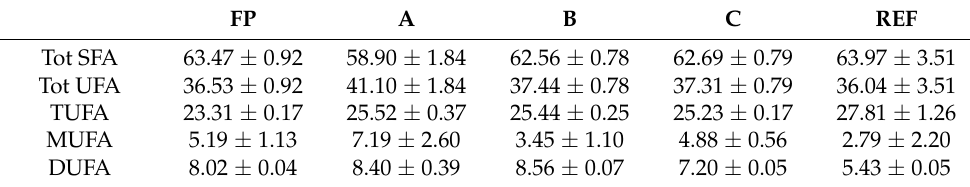
Table 4. Fatty acid percentages (molar % ± SD) by NMR analysis of the pumpkins Bligh–Dyer organic fractions reported for fresh and packaged pumpkin samples. FP = fresh pumpkin